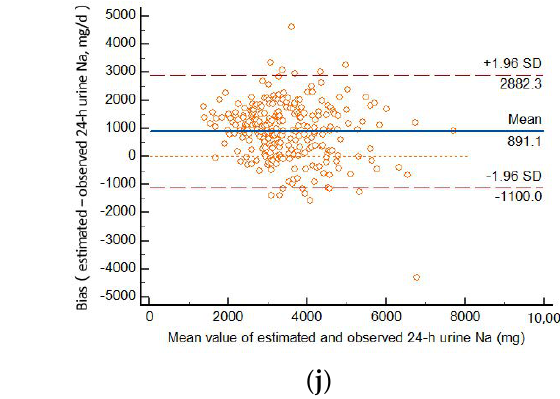
Figure 1. Bland – Altman plot of the bias (difference) between predicted and measured 24-h urinary sodium excretion in summer, based on INTERSALT equation ( a ) and Tanaka equation ( b ) in the morning, INTERSALT equation ( c ), Tanaka equation ( d ) and Sun’s equation ( e ) in the afternoon, INTERSALT equation ( f ) and Tanaka equation ( g ) in the evening, and INTERSALT equation ( h ), Tanaka equation ( i ) and Kawasaki equation ( j ) overnight.